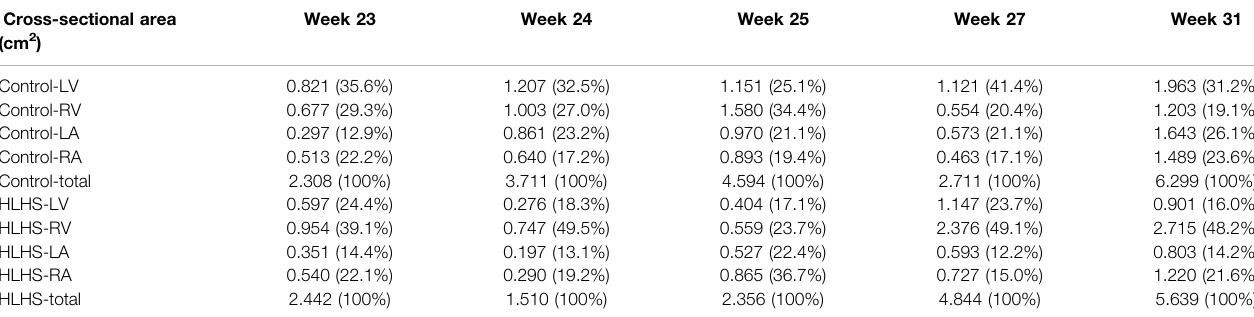
TABLE 4 | The comparison of averaged heart chamber cross-sectional areas between the control and HLHS hearts. The values given in parenthesis are the percentages with respect to the total cross-sectional area of the fetal heart. Cross-sectional area (cm 2